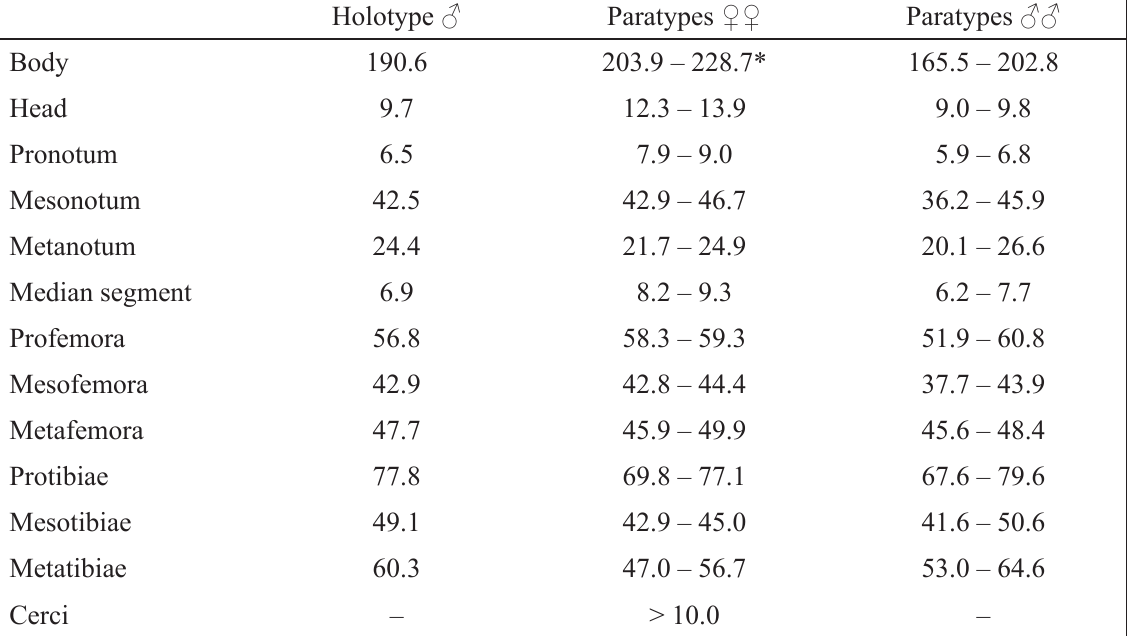
Table 2. Measurements (mm) of Phryganistria tamdaoensis sp.